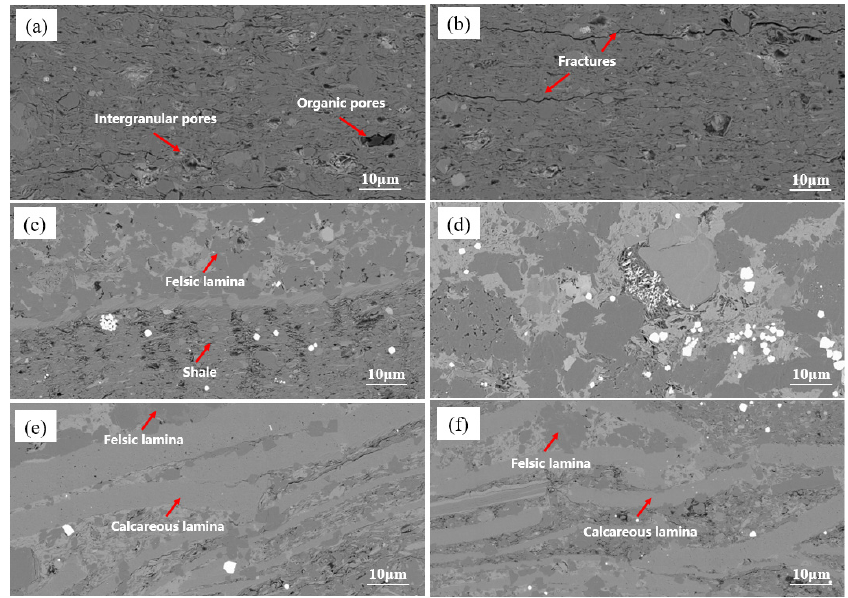
Figure 6. SEM analysis of shale samples: ( a , b ) foliaceous shale; ( c , d ) laminated feisic shale and ( e , f ) laminated diamictic shale.